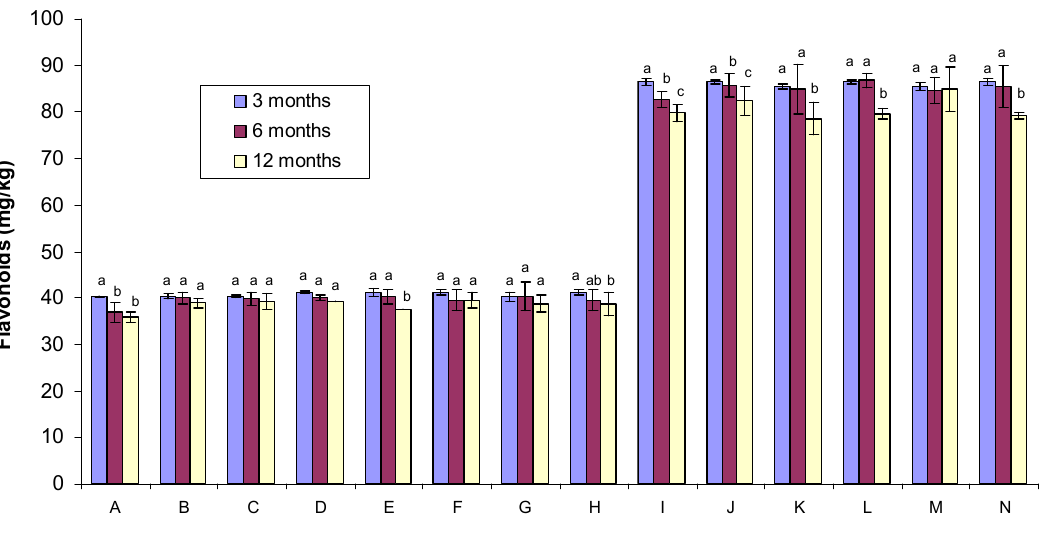
Figure 2. Comparison of the flavonoid content of Tualang honey samples exposed to different storage conditions (the data obtained after 6 and 12 months were compared with the baseline data obtained after three months). Different letters (a, b and c) indicate significant differences ( p < 0.05). The letters “A” to “N” indicate the sample code (Table 1).